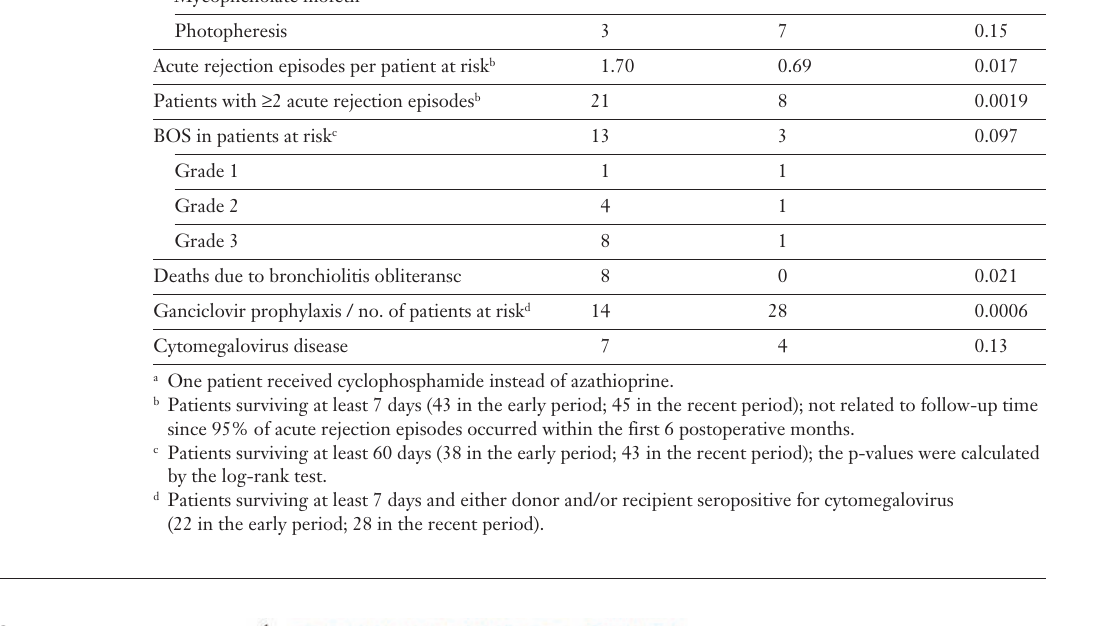
Kaplan-Meier esti- mates of the cumula- tive incidence of freedom from death due to bronchiolitis obliterans syndrome. The difference be- tween the early and the recent period was calculated by the log-rank